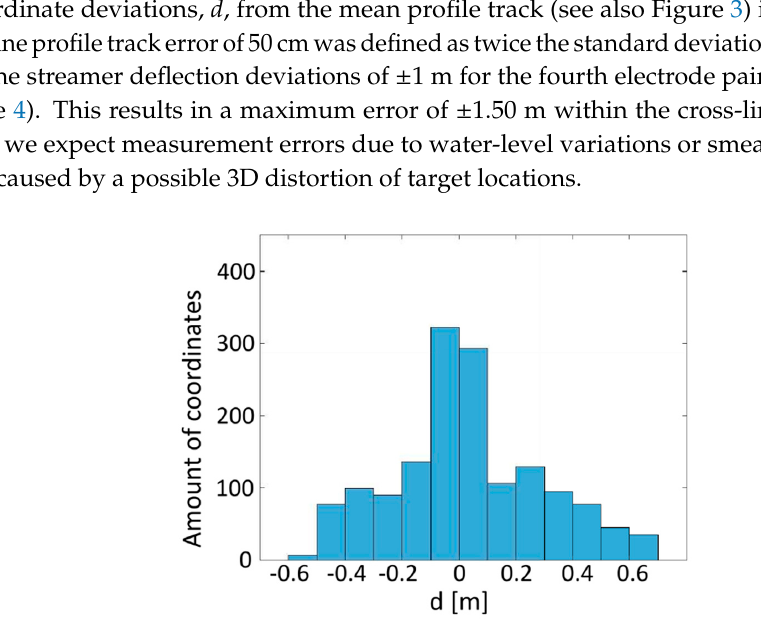
Figure 8. Histogram of GNSS (global navigation satellite systems) coordinate deviations, d , of all towed profiles from the average measurement profile calculated from a regression curve of the coordinates.